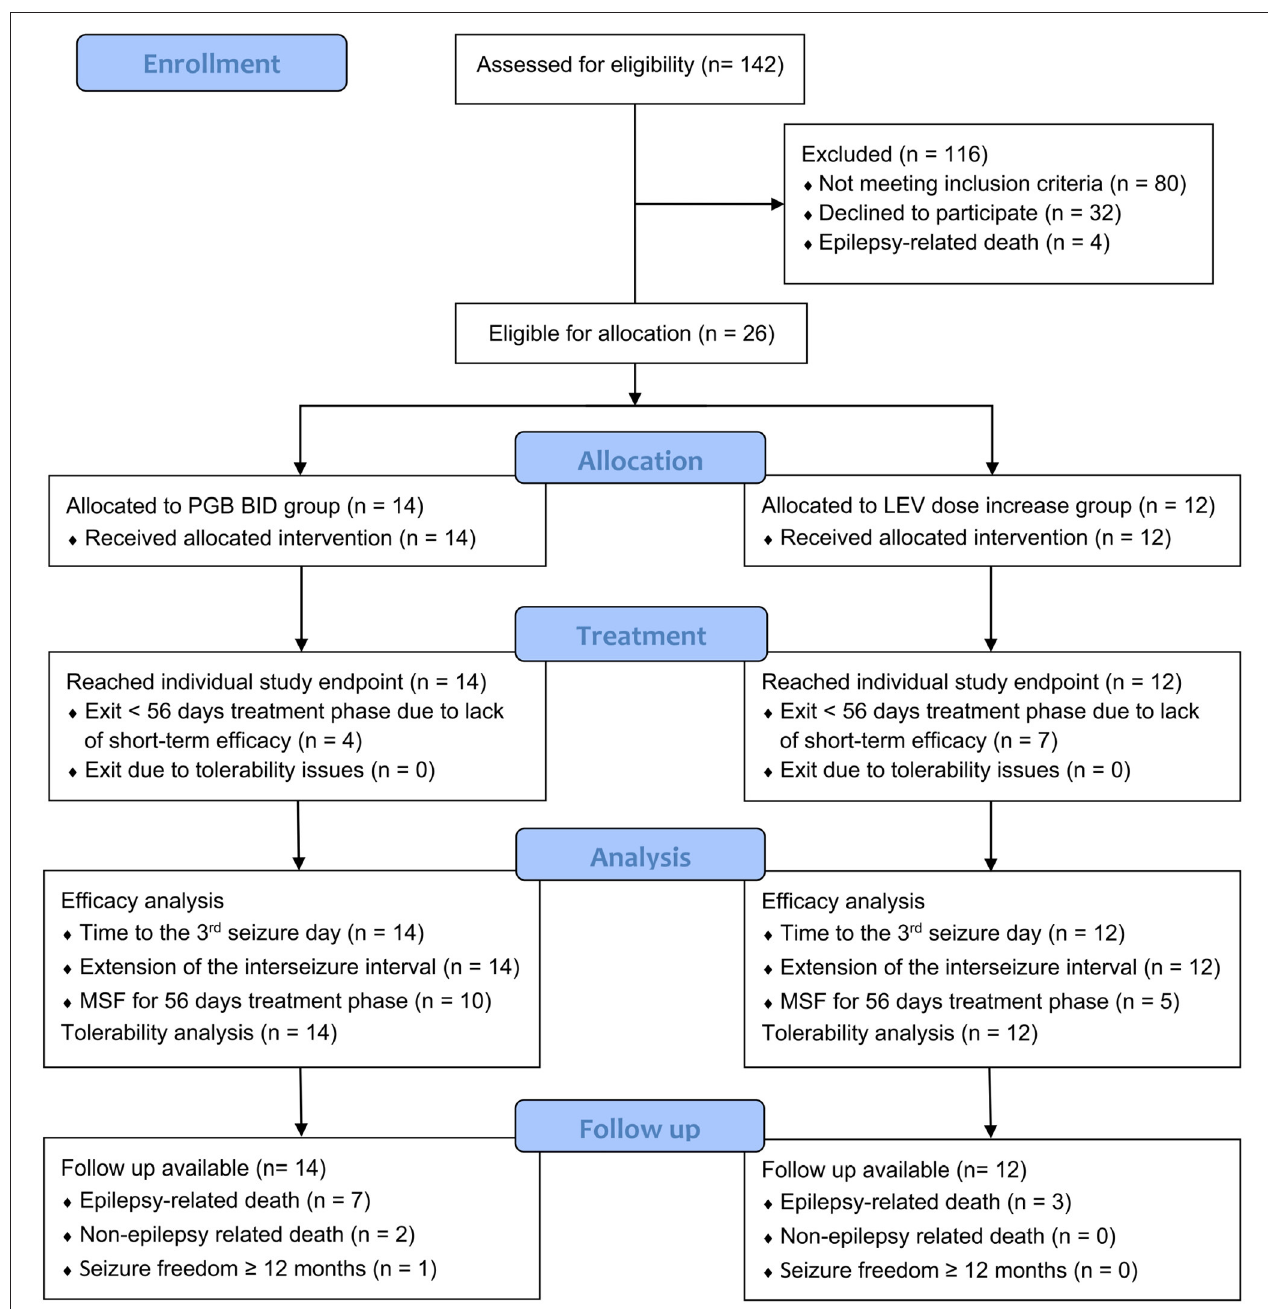
FIGURE 1 | CONSORT flow diagram of study design. Twenty-six dogs were allocated to one of two treatment arms by stratified randomization. All dogs reached their individual study endpoint, which was minimum the 3rd day with generalized tonic–clonic seizures. Follow-up was available from all dogs. PGB, pregabalin; BID, dosing q12 hours; LEV, levetiracetam